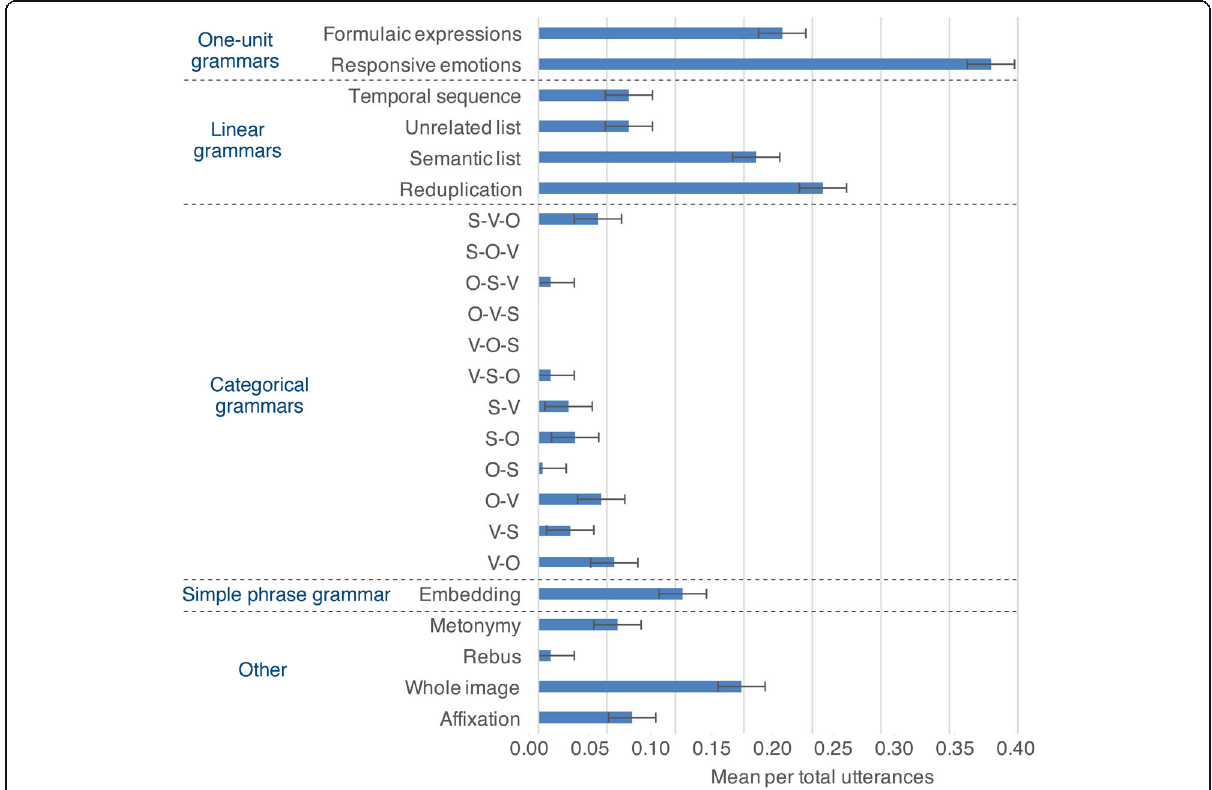
Fig. 2 Types of utterances used in emoji-only conversations. Error bars depict standard error. O object, S subject, V